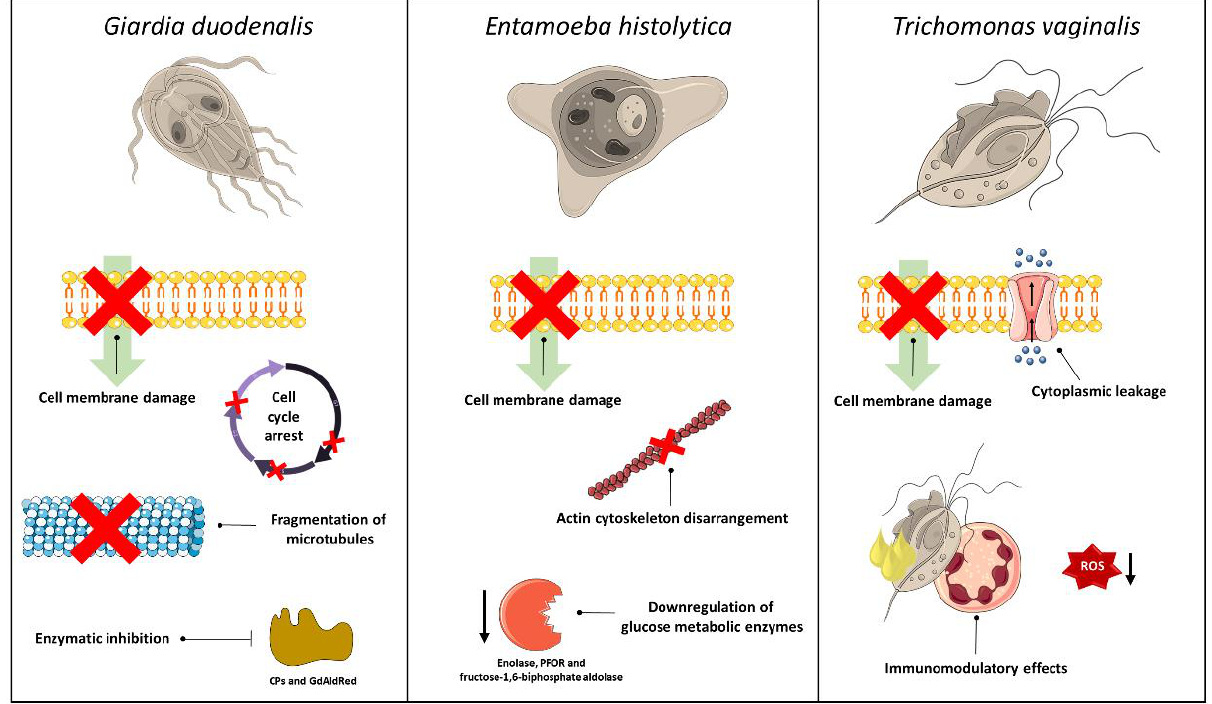
Figure 2. Possible mechanisms of action displayed by essential oils and terpenic compounds on amitochondriate parasites.